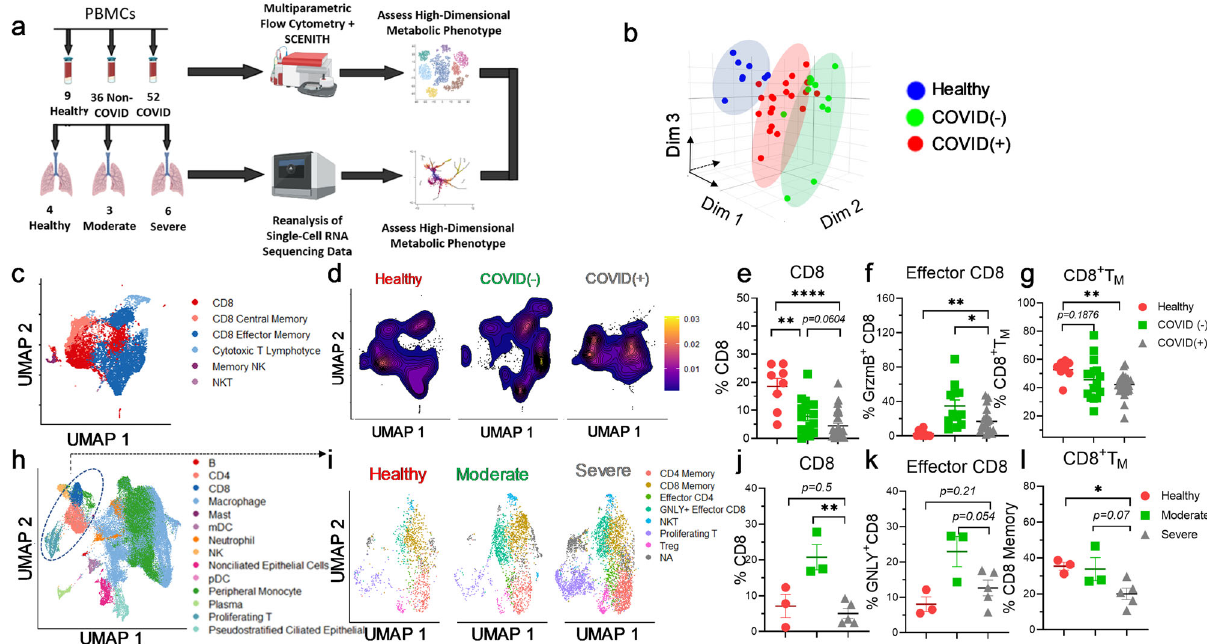
Fig. 1 Distinct immunophenotype of BALFs and PBPMCs from COVID-19 patients. a Schematic illustrating experimental design for multiparametric fl ow cytometry and single-cell RNA-sequencing re-analysis. b – g The total PBMC patient cohort includes 9 healthy, 36 COVID( – ), and 52 COVID-19 + patients; given the high degree of lymphopenia, various subsets of the total cohort were used for different experiments. h – l The total BALF patient cohort includes 4 healthy, 3 moderate COVID-19, and 6 severe COVID-19 patients. One healthy and one severe patient was excluded from downstream analysis due to low T-cell count. b 3D PCA analysis conducted using bulk expression of each marker per sample as input; circles were manually drawn around the PCA plot to highlight distinct clustering. c UMAP projection of labeled PBMC populations from 8 Healthy (HD), 12 COVID ( − ) (C − ), and 17 COVID ( + ) (C + ) patients. d Representative contoured kernel density for UMAP projection of PBMCs, a representative sample from each group was displayed. e – g Summary graphs demonstrating frequency of CD8 + Tc amongst all live cells in patient PBMCs ( n = 8 HD,15 COVID ( − ), 27 C + ). e frequency of effector CD8Tc (grzmB + CD8Tc) amongst all CD8 + Tc ( n = 8 HD, 12 C − , 20 C + ) ( f ), and frequency of CD8 + Tc memory (CD8 + T M ) amongst all CD8 + Tc ( n = 8 HD, 16 C − , 26 C + ) ( g ). h UMAP projection displaying population labeling of 66,452 cells from healthy (HD), moderate (M), and severe (S) COVID-19 + patients, Tc populations were circled manually. i UMAP projections displaying labeled unsupervised clustering analysis of 7601 reintegrated cells split between healthy, moderate, and severe COVID-19 + patients. j – l Summary graphs demonstrating frequency of bulk CD8 + Tc amongst total BALF cells ( n = 3 HD, 3 M, 5 S) ( j ), effector CD8 + Tc among all Tc ( n = 3 HD, 3 M, 5 S) ( k ), and CD8 + Tc memory (CD8 + T M ) ( n = 3 HD, 3 Moderate (M), 5 Severe (S), ( l ) amongst all Tc. Two-tailed student ’ s t test was used. * p < 0.05, ** p < 0.01, and *** p < 0.001. Biorender was used in part to create the schematic in a ; appropriate license and permission to use fi gure in publication were